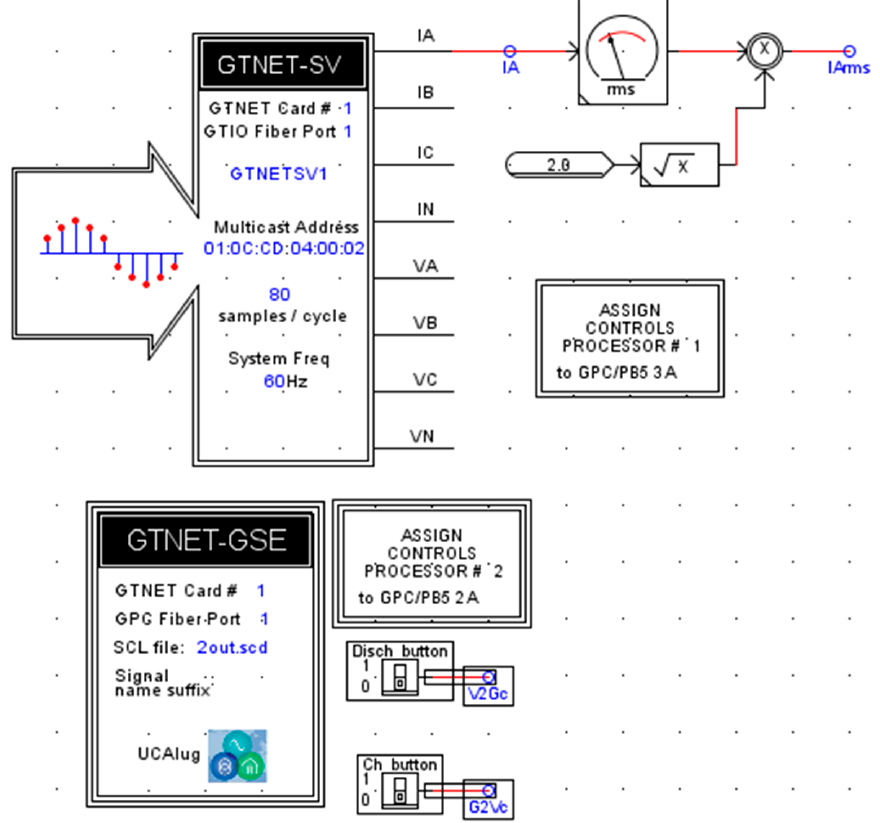
Figure 4. SV and GOOSE message configuration for a charging station.